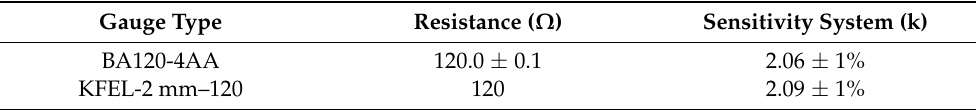
Figure 2. Two kinds of explosives. ( a ) PETN; ( b ) RDX/TNT. A strain gauge was pasted on the outer wall of the cylindrical shell to measure the dynamic strain and to understand the stress and deformation of the container. Parameters of stain gauge are shown in Table 2. From the center of the explosion, four strain measuring points were laid at 0 mm, R, and 2R, respectively, each being divided into two channels of a toroidal and axial signals, forming a total of eight channels of signals and eight test cables. The signal produced and then amplified by the strain gauge was transmitted to the oscilloscope for recording. Table 2. Strain gauge.